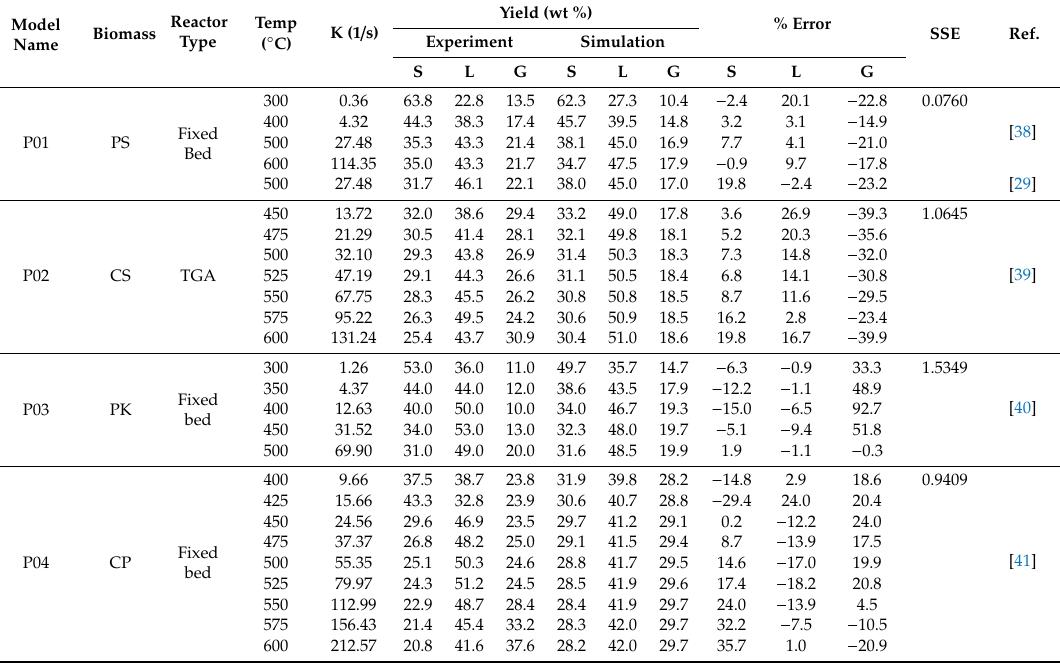
Table 5. Comparison of experimental and simulated pyrolysis product yields using data from previous works.